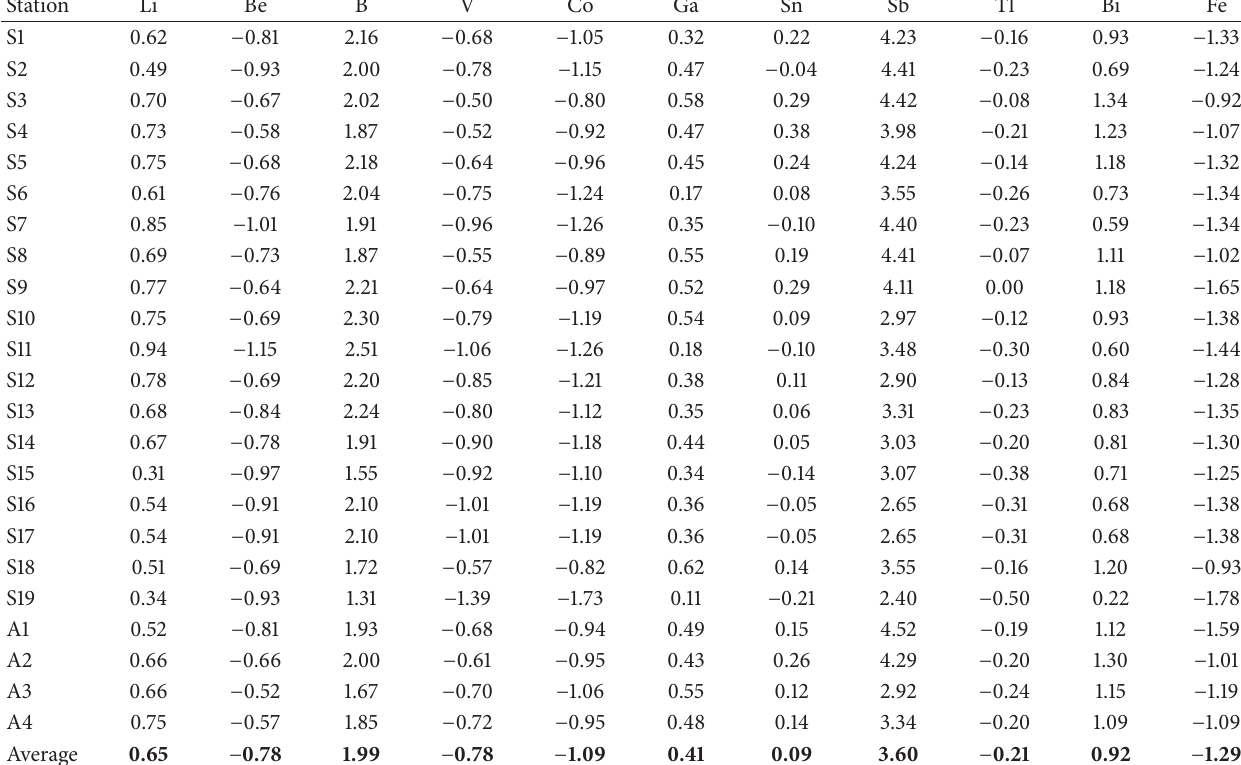
Table 4: 𝐼 values of SMTEs in sediments of Three Gorges Reservoir. geo